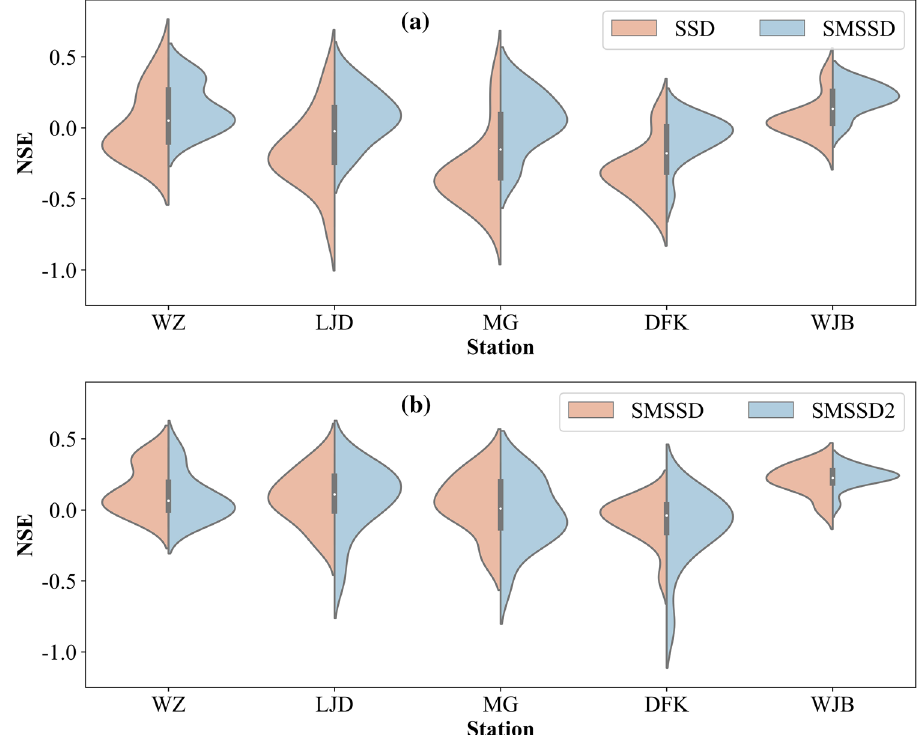
Fig. 16 a SSD-based and SMSSD-based and b SMSSD- based and SMSSD2-based violin plots of the DWT-LSTM model